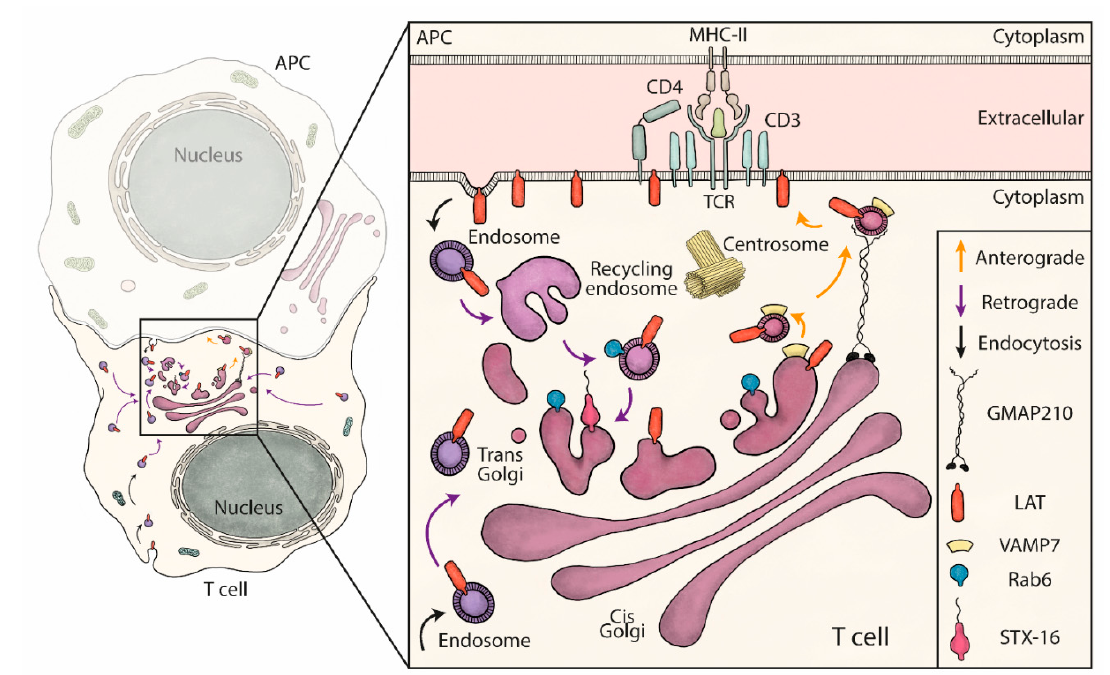
Figure 5. Schematic summary: retrograde and anterograde pathways coordinate the delivery of vesicles containing LAT to the immune synapse. LAT constitutively recycles from the plasma membrane to early/recycling endosomes. Vesicles from this compartment undergo a retrograde transport to the Golgi apparatus, which is increased upon TCR activation. Rab6 and Syntaxin-16 (inset), control specifically this retrograde transport. Once in the Golgi, the anterograde pathway delivers LAT to the IS. In this second step, LAT meets in the Golgi the vesicular SNARE VAMP7 and GMAP210 sorts, captures and brings the LAT/VAMP7 vesicles to the immune synapse.